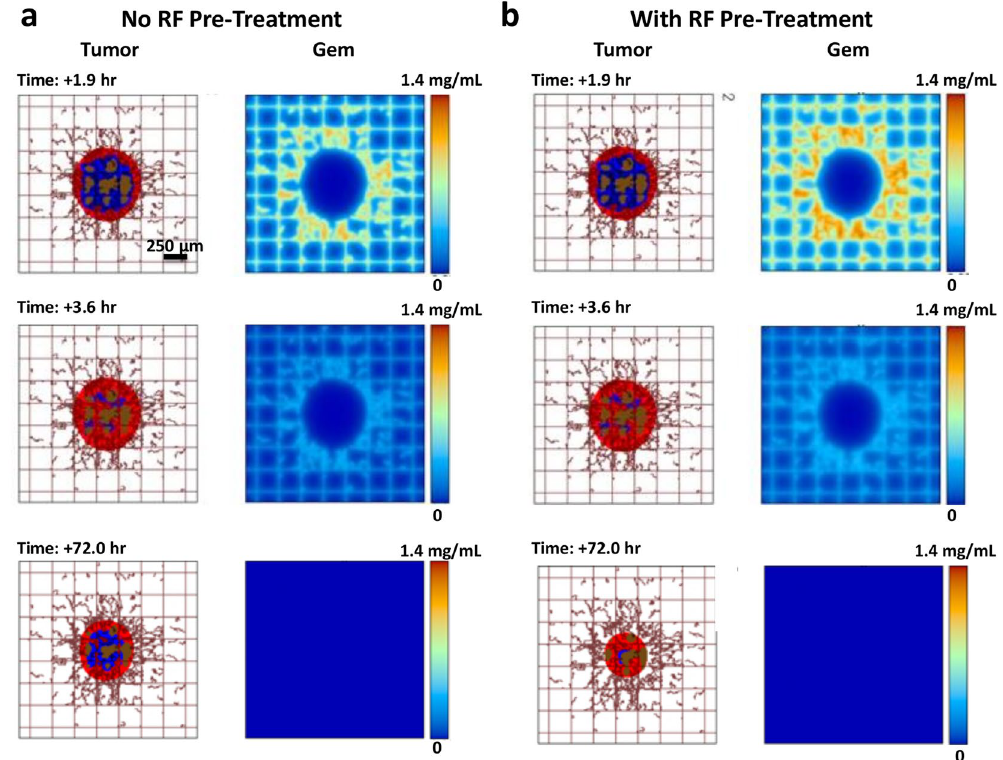
Figure 6. Simulation of combination RF and Gem treatment. ( a ) Gem with no RF pre-treatment; ( b ) Gem with RF pre-treatment. For each panel, vascular flow is from bottom left to upper right. Tumor tissue includes proliferating (red), hypoxic (blue) and necrotic (brown) regions. Existing capillary network is denoted by regularly spaced grid (brown), with vessels induced by angiogenesis shown as irregular lines growing towards the hypoxic tumor regions acting as a source of angiogenic stimuli. At 1.9 hr post injection, the drug concentration is high. Over the course of 3.6 hr, most of the drug washes out. By 72 hr, tumor lesion has visibly shrunk due to the drug effect.